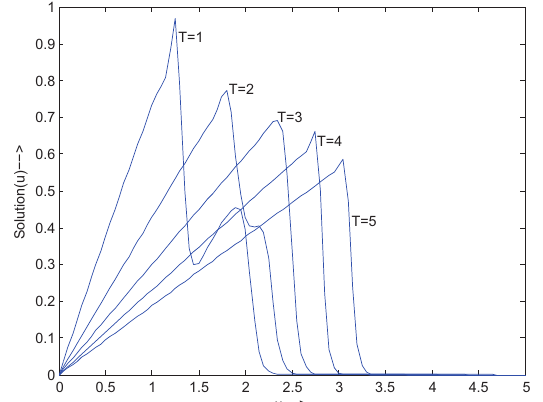
Fig. 8: Example 4: Solution profiles for T ≤ 5 , ν = 0.01 , Δt = 0.001 and Δx =